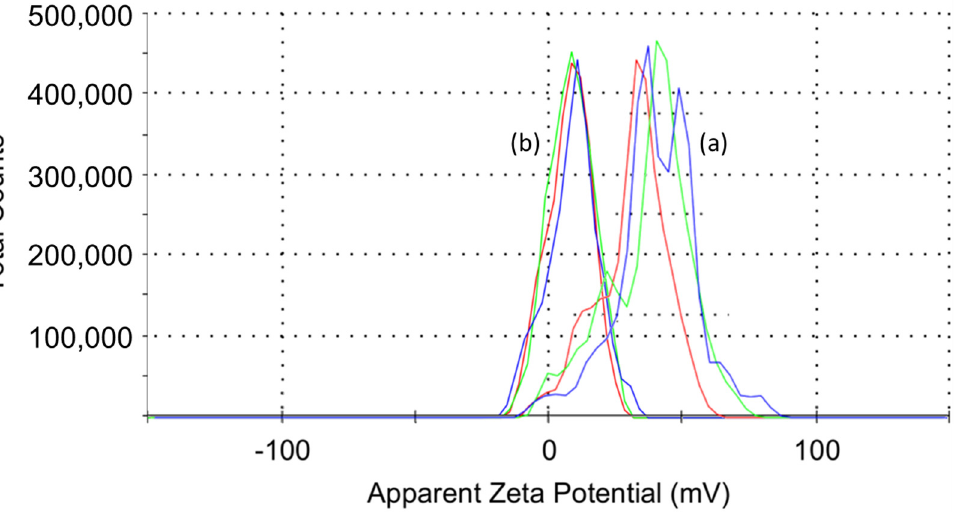
Figure 3. Zeta potential values of ( a ) nHA and ( b ) S-HA nanoparticles. The zeta potential value of nHA was different each time it was measured due to aggregation in distilled water. On the other hand, S-HA had almost no aggregation, so the dispersing power was improved, and as a result, the same value was displayed every time it was measured.